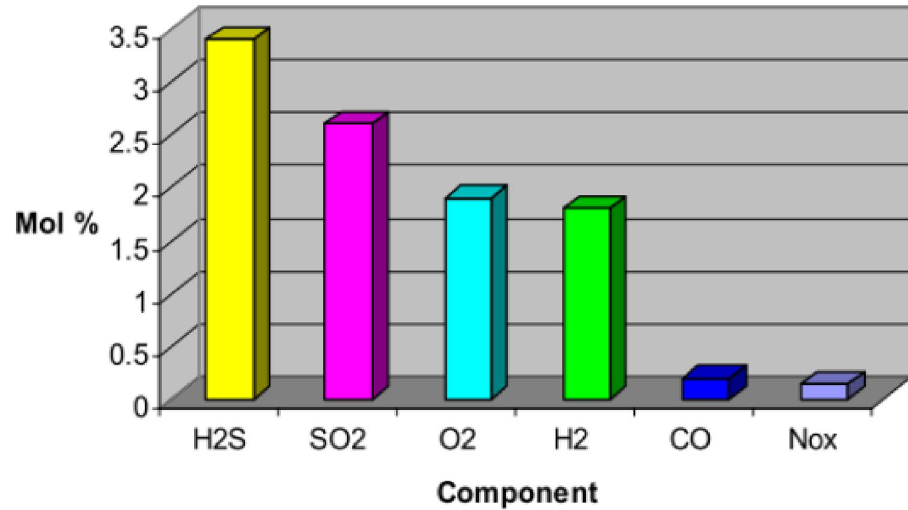
Fig. 3 Possibility on the